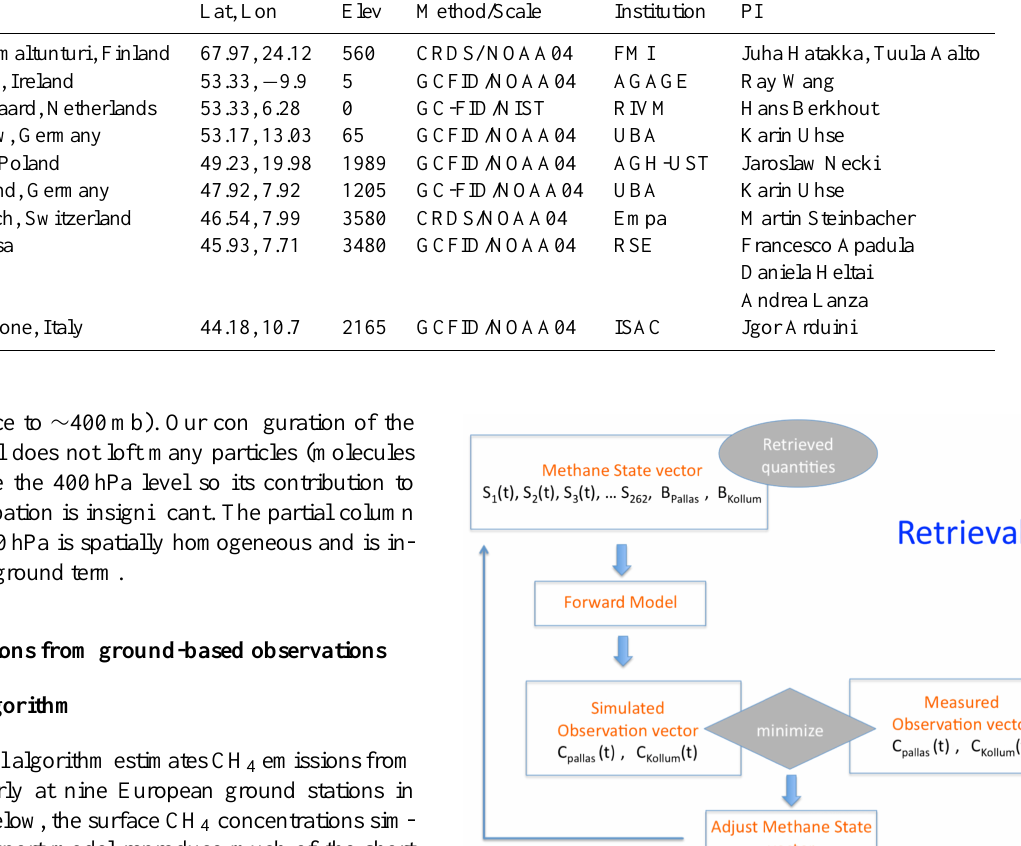
Table 1. Ground stations sampling hourly methane concentrations used in this study. Elevation is in meters. CRDS is Cavity Ring Down Spectrometry and GC-FID is Gas Chromatography with Flame Ionization Detector. Station Lat, Lon Elev